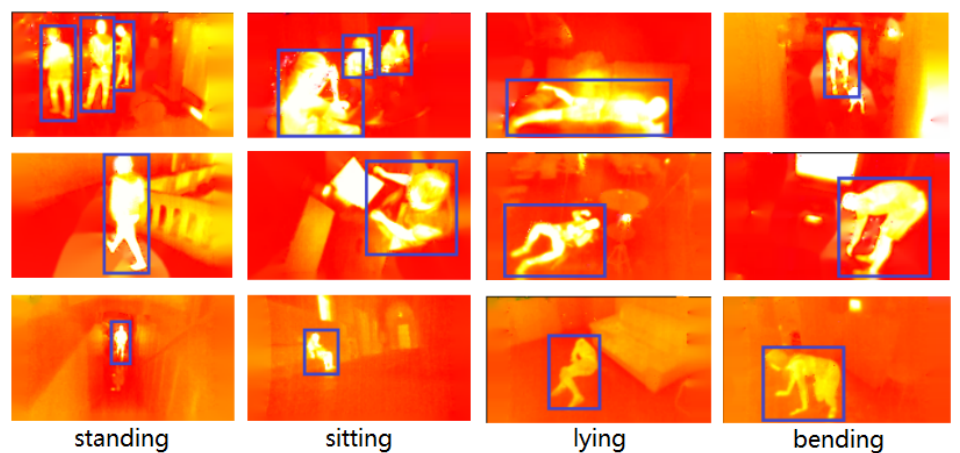
Figure 2. Samples images of persons with four human postures (i.e., ‘standing’, ‘sitting’, ‘lying’, and ‘bending’ from left to right) in the proposed IPHPDT dataset. The objects are identified by blue bounding